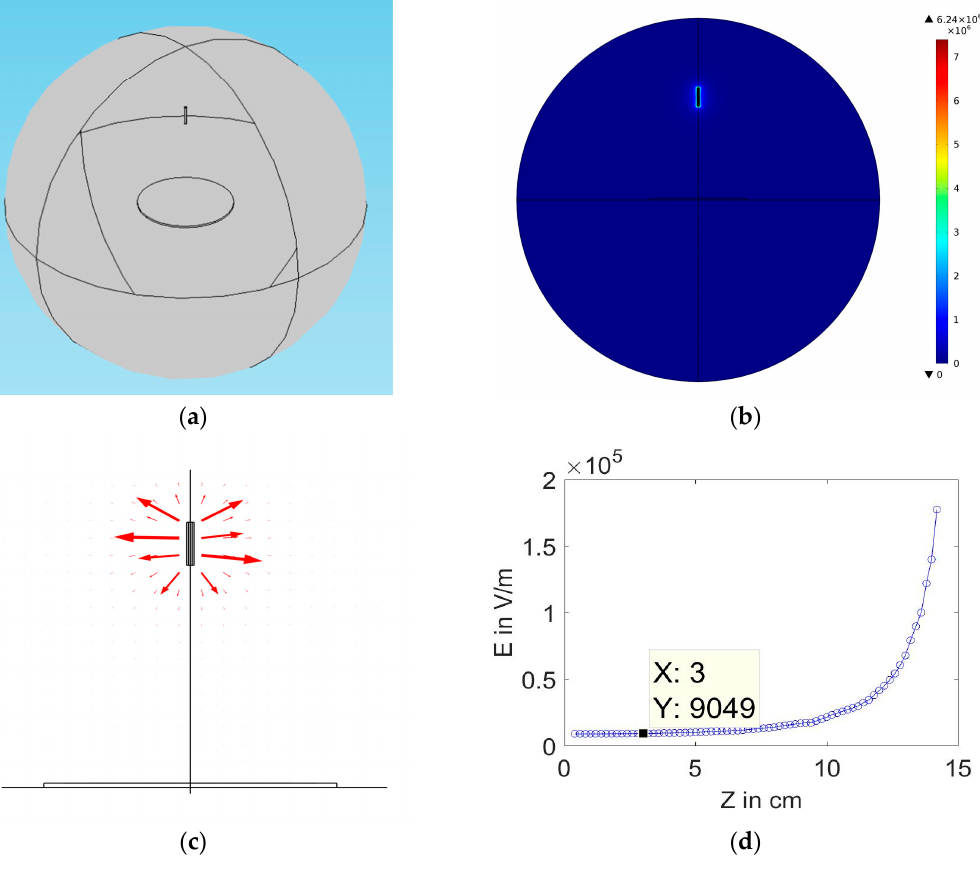
Figure 3. ( a ) Needle in typical electrosspinning setup in COMSOL software, ( b ) Electric field distribution surrounding to the needle spinnert at (d = 15 cm, V = 15 kV), ( c ) Mapping of electric field lines, and ( d ) Variation of electric field magnitude along z-axis, which presents the distance between the feeder and collector.